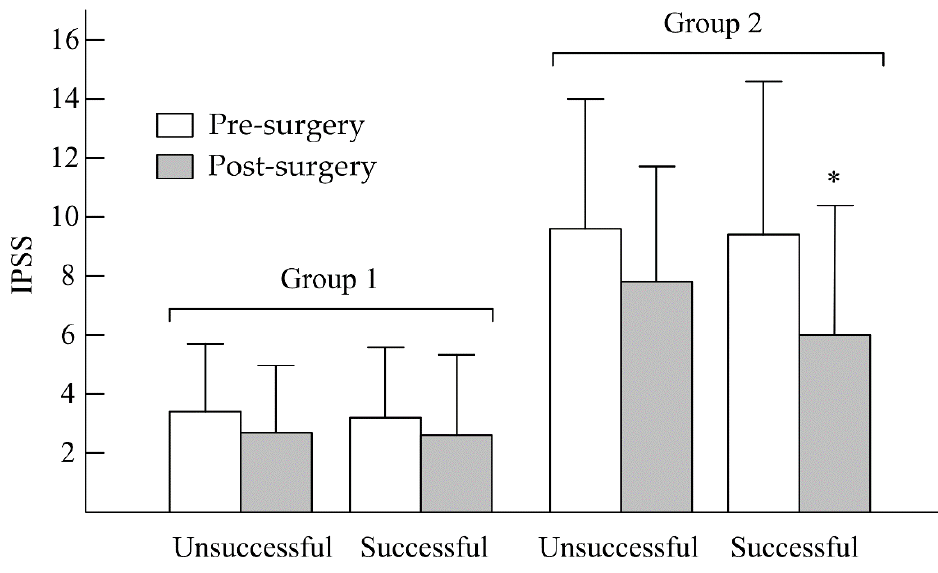
Figure 1. Changes in IPSS between pre- and post-uvulopalatopharyngoplasty (UPPP) in non-nocturia (group 1) and nocturia (group 2) patients. * p < 0.05, pre- vs. post-UPPP.